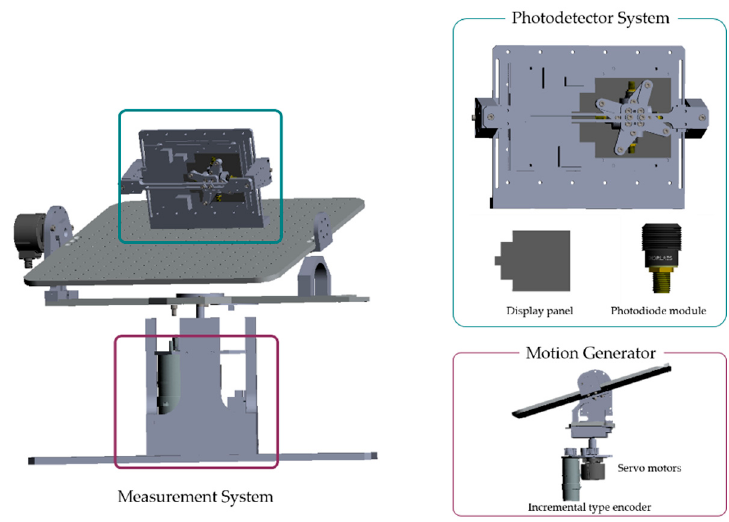
Figure 2. Overall architecture of the previously proposed motion-to-photon latency measurement system.